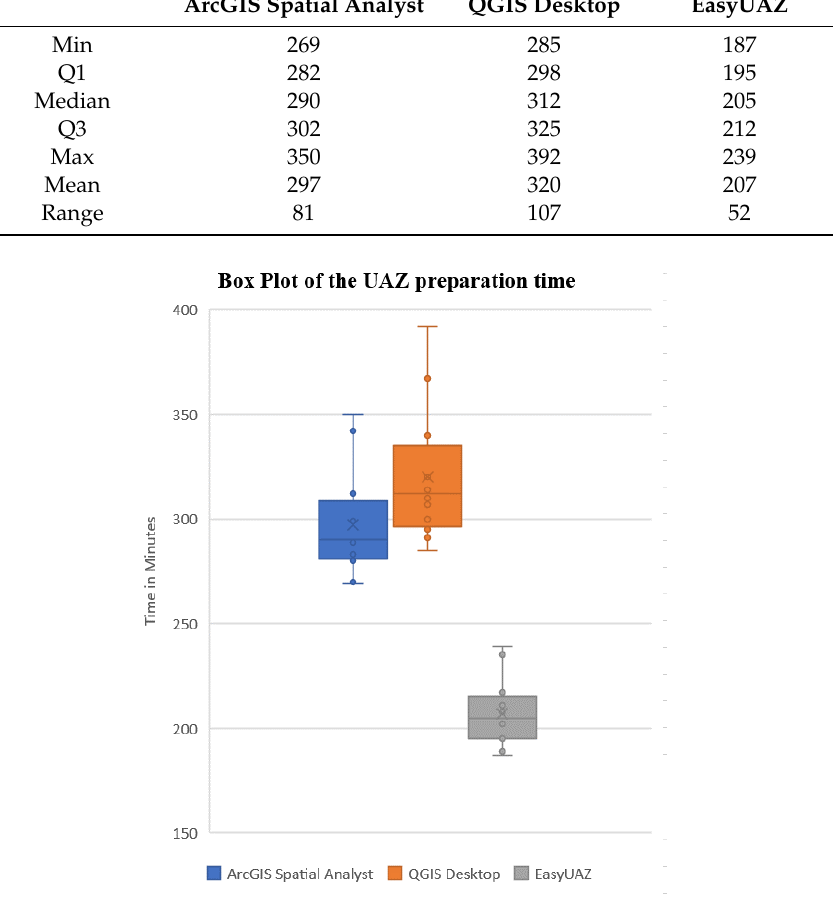
Figure 11. Box plot of UAZ preparation time (minutes).